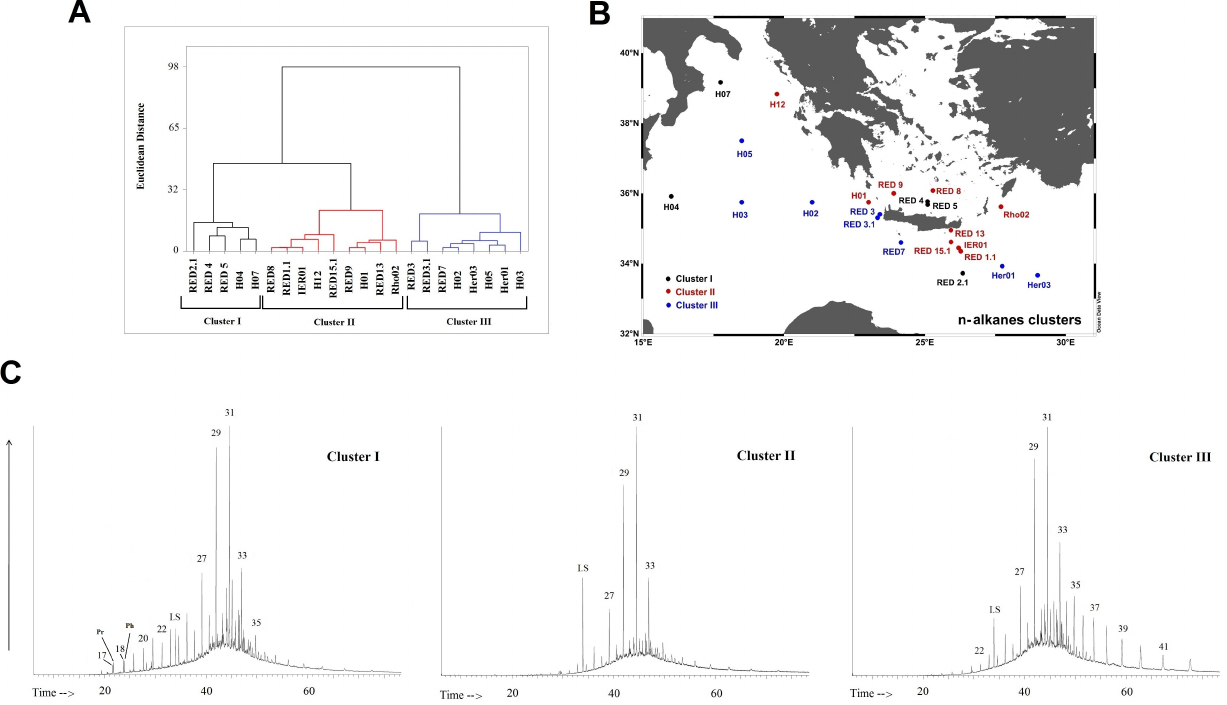
Fig. 7. Hierarchical diagram obtained from cluster analysis of stations with regard to n -alkane profile (A) , clustered stations (B) and char- acteristic GC-MS traces for each returning cluster (C) . NA homologues are assigned with their number of carbon atoms. Pr: pristane; Ph: phytane; I.S: internal